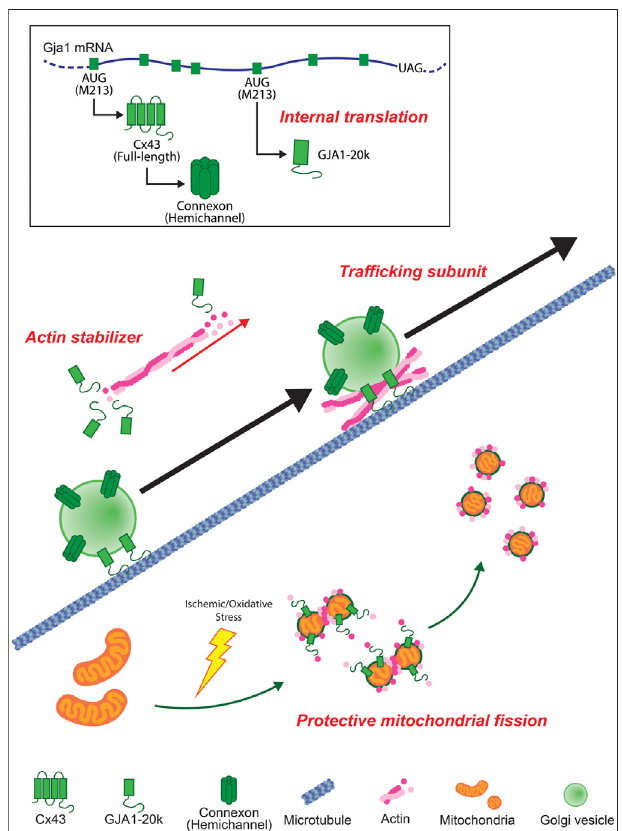
FIGURE 4 | Schematic summary of GJA1-20k. GJA1-20k is generated by internal translation of Gja1 mRNA. GJA1-20k works not only asan auxiliary traf fi cking subunit for full-length Cx43 hemichannels to cell-cell borders but also as an actin stabilizer. In mitochondria, GJA1-20k is upregulated by ischemic/oxidative stress and works with actin to induce a protective mitochondrial fi